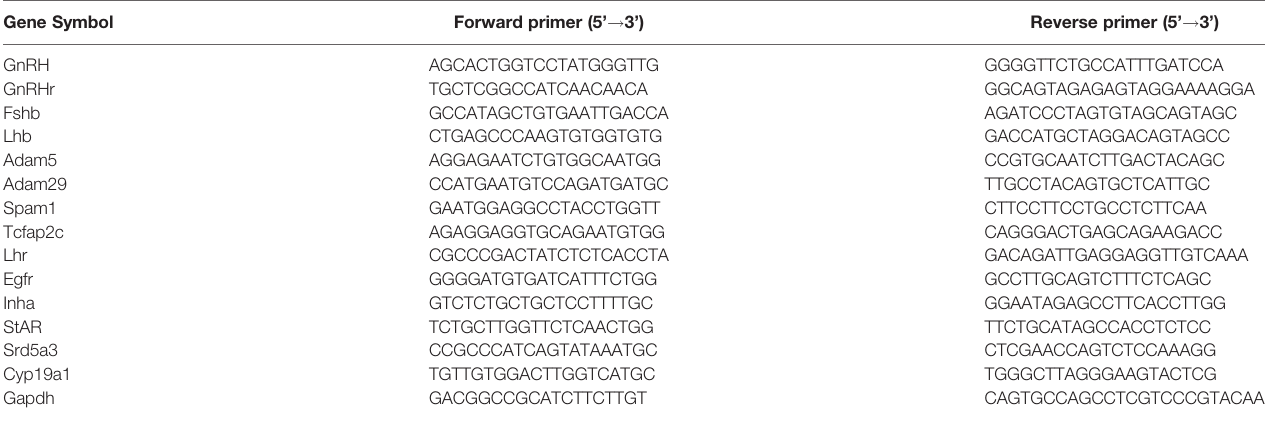
TABLE 1 | Details of the primers used in this study.